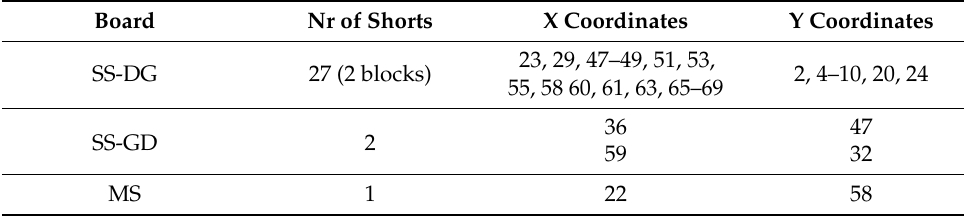
Table 1. Shorts circuit traces in readout boards.